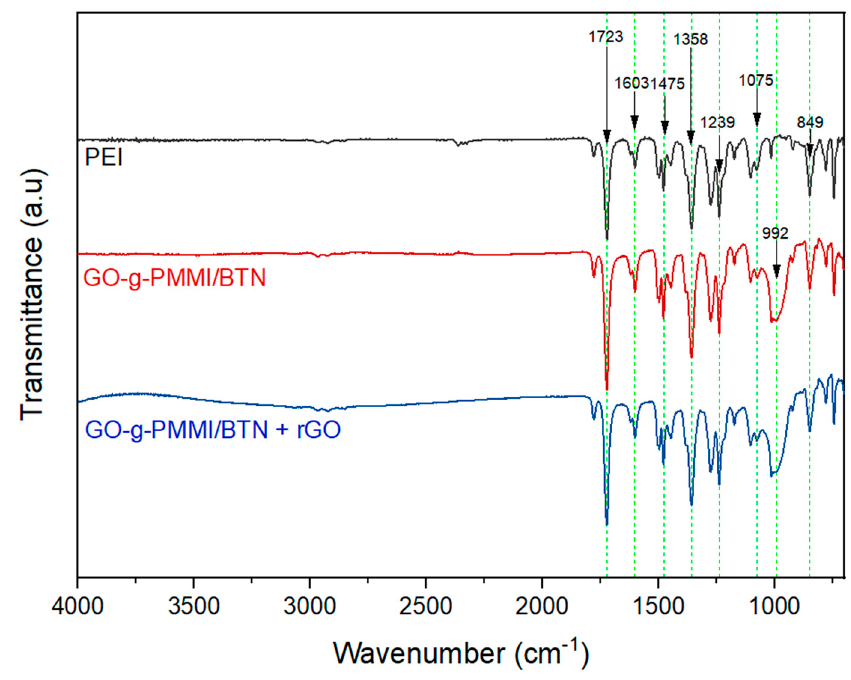
Figure 8. FTIR spectra of GO-g-PMMI/BTN nanocomposite and GO-g-PMMI/BTN + rGO